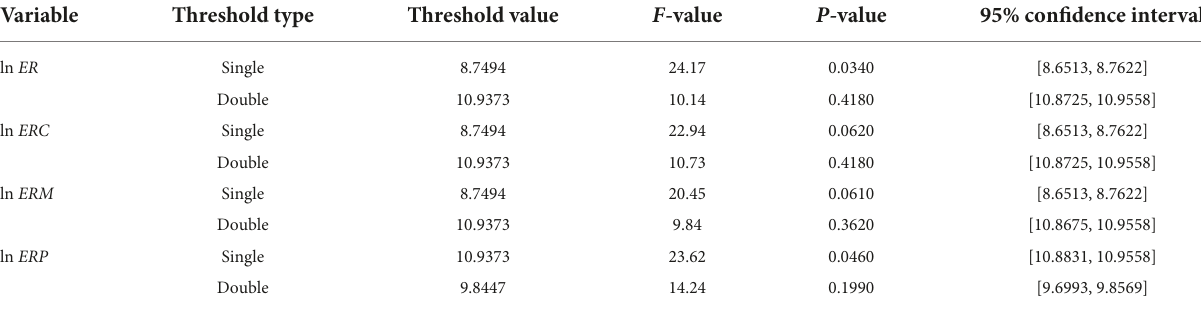
TABLE 5 Test of the threshold effect of technological progress.